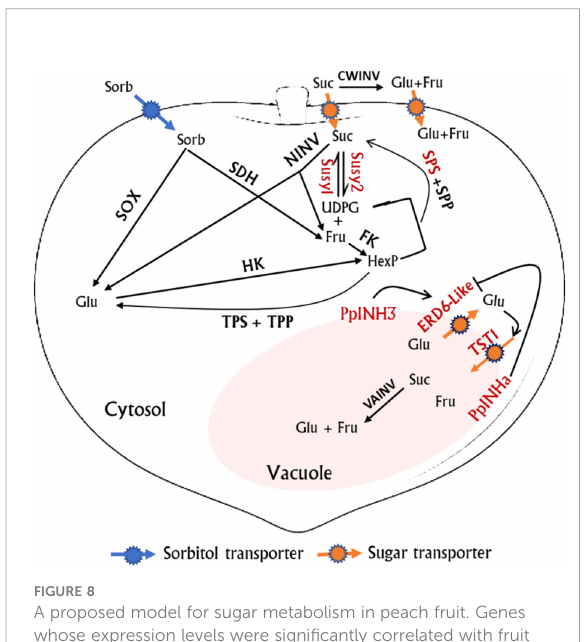
FIGURE 8 A proposed model for sugar metabolism in peach fruit. Genes whose expression levels were signi fi cantly correlated with fruit sugar content are highlighted in red color. Red streamline indicates activation. Suc, sucrose; Sorb, Sorbitol; Glu, Glucose; Fru, Fructose; UDPG, uridine diphosphate glucose; TPP, Trehalose phosphate phosphatase; TPS, trehalose phosphate synthase; and HexP, hexose